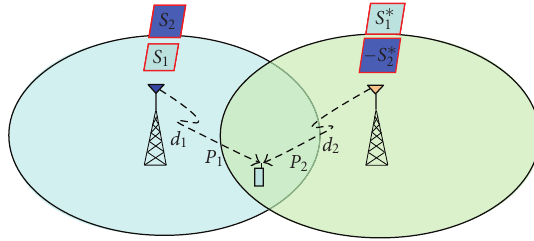
Figure 5: Alamouti scheme in SFN environment.